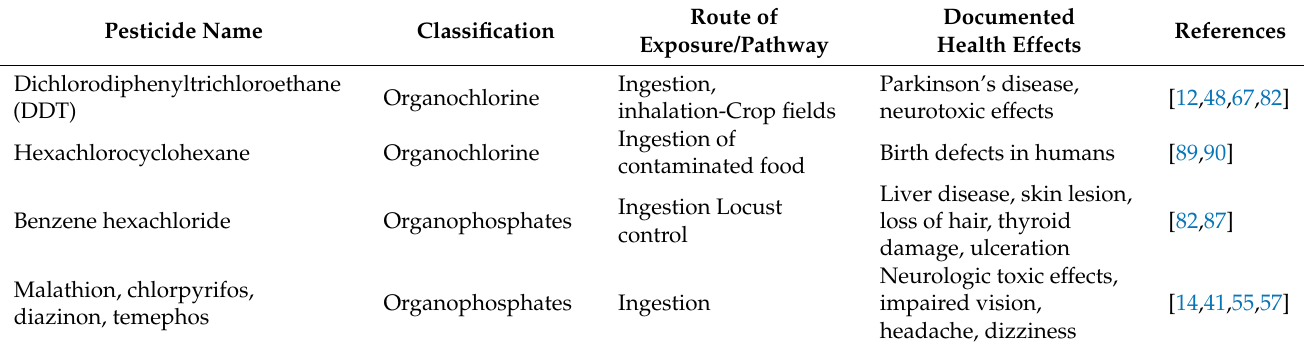
Table 2. Summary of the classification of pesticides and human health